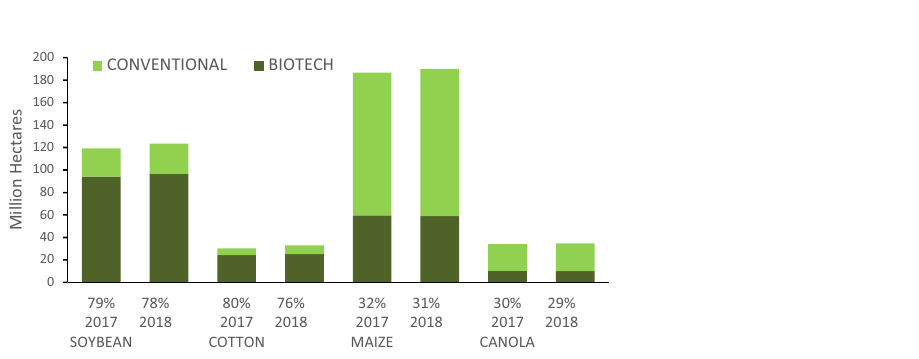
Figure 3. Global area and adoption rate (%) for top 4 Biotech crops (Million hectares) in 2017 and 2018 33